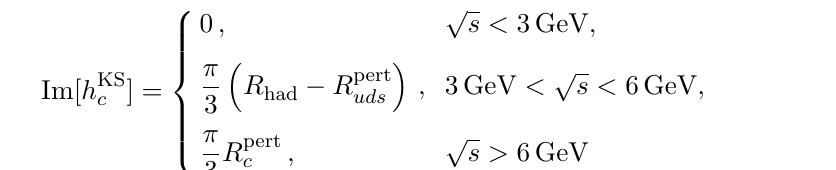
Figure 4 . \Hairpin-turn" diagram in QCD which is the origin of its nonperturbative enhancement for low momentum